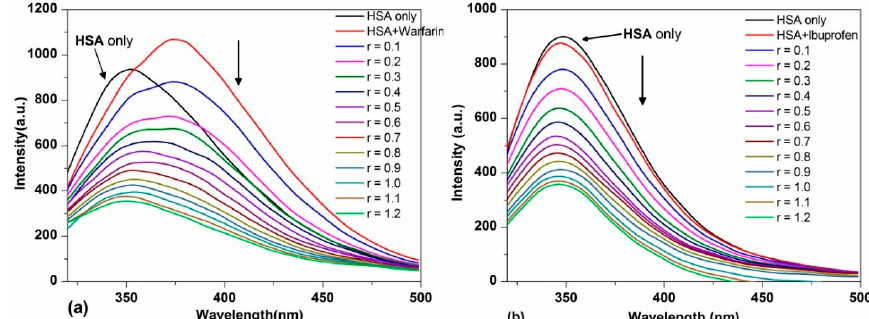
Figure 8. Fluorescence spectra changes of HSA (5 μ M) in the presence of equimolar warfarin ( a ) and HSA-ibuprofen ( b ) in Buffer IV (pH = 7.4) solution (Pre-incubated for 5 min) with the addition of TCPC ( r = [TCPC]/[HSA]).